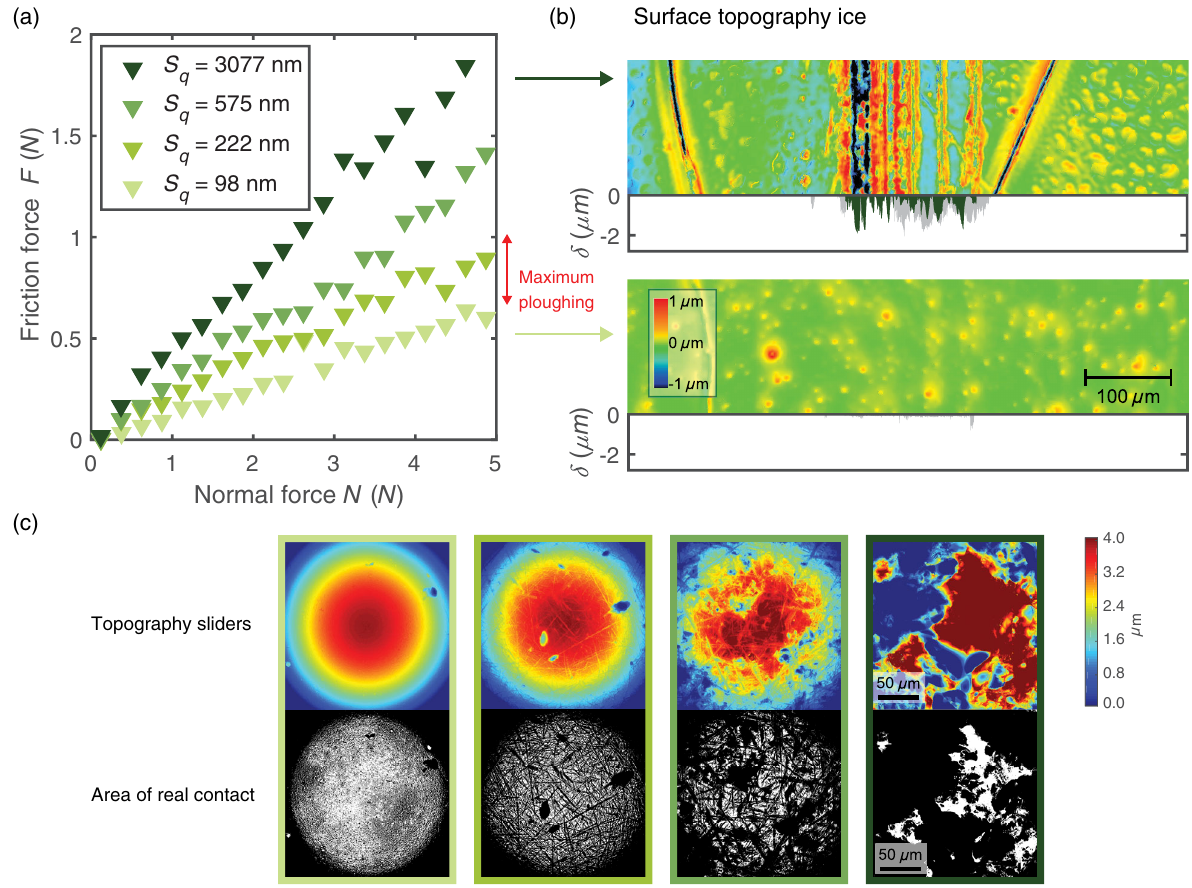
FIG. 3. (a) Friction force as a function of normal force measured for glass spheres with surface roughness S q of 98, 222, 575, and 3077 nm at a temperature of − 50 °C and sliding speed of 0 . 38 mm = s. The smoothest sphere displays a friction equal to that reported in Fig. 1, which can be described by the Arrhenius equation [Eq. (1)]. For increasing surface roughness, a higher friction force is measured. (b) Surface topography and corresponding ploughing depth δ in the ice after a sphere with the highest (top) and lowest (bottom) roughness slides over it at a normal force of 0.21 N. The calculated plastic indentation depth δ for a normal force of 0.21 N is added in light gray in the insets. (c) Surface topography (top) and calculated area of real contact (bottom) for the same glass spheres at T ¼ − 50 °C at a normal force of 0.5 N. A transition from primarily elastic contact for a smooth slider towards elastic-plastic contact for a rough slider can be